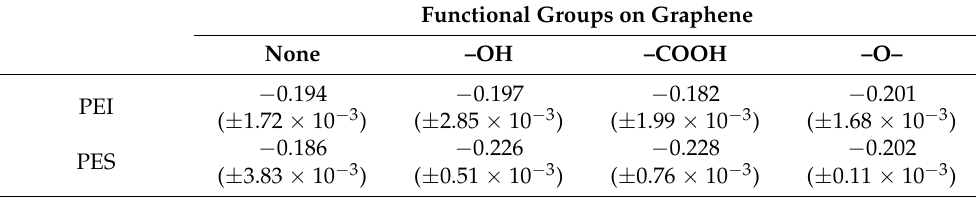
Table 1. Calculation results of the interfacial energy mean value and the error, respectively.